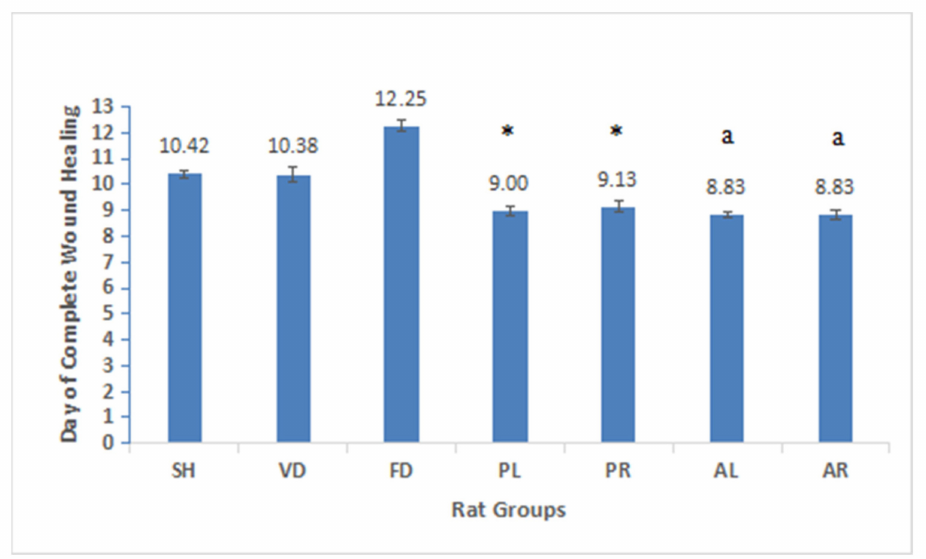
Figure 3. The day of complete wound healing seven male rat experimental groups: sham-operated SH, vehicle dressing (VD), flavine dressing (FD), MPvp leaves (PL), MPvp roots (PR), MPva leaves (AL), and MPva roots (AR). All data are given as mean ± S.E. for six animals in each group. Statisti- cally significant results are indicated as (*) p < 0.05 versus untreated and control groups (SH, VD, and FD) and (a) p < 0.001 versus untreated and control groups (SH, VD, and FD). SH: sham control group (without treatment); VD: treated with vehicle (Cetomacrogol ointment); FD: treated with flavine (Acriflavine 0.1%); PL: treated with 1.0% concentration of MPvp leaves extract; PR: treated with 1.0% concentration of MPvp stem roots extract; AL: treated with 2.0% concentration of MPva leaves extract; AR: treated with 2.0% concentration of MPva stem roots extract. Table 3. Macroscopical observation of seven male rat experimental groups: SH, VD, FD, PL, PR, AL, and AR on a daily basis. SH: sham control group (without treatment); VD: treated with vehicle (Cetomacrogol ointment); FD: treated with flavine (Acriflavine 0.1%); PL: treated with 1.0% concen- tration of MPvp leaves extract; PR: treated with 1.0% concentration of MPvp stem roots extract; AL: treated with 2.0% concentration of MPva leaves extract; AR: treated with 2.0% concentration of MPva stem roots extract.